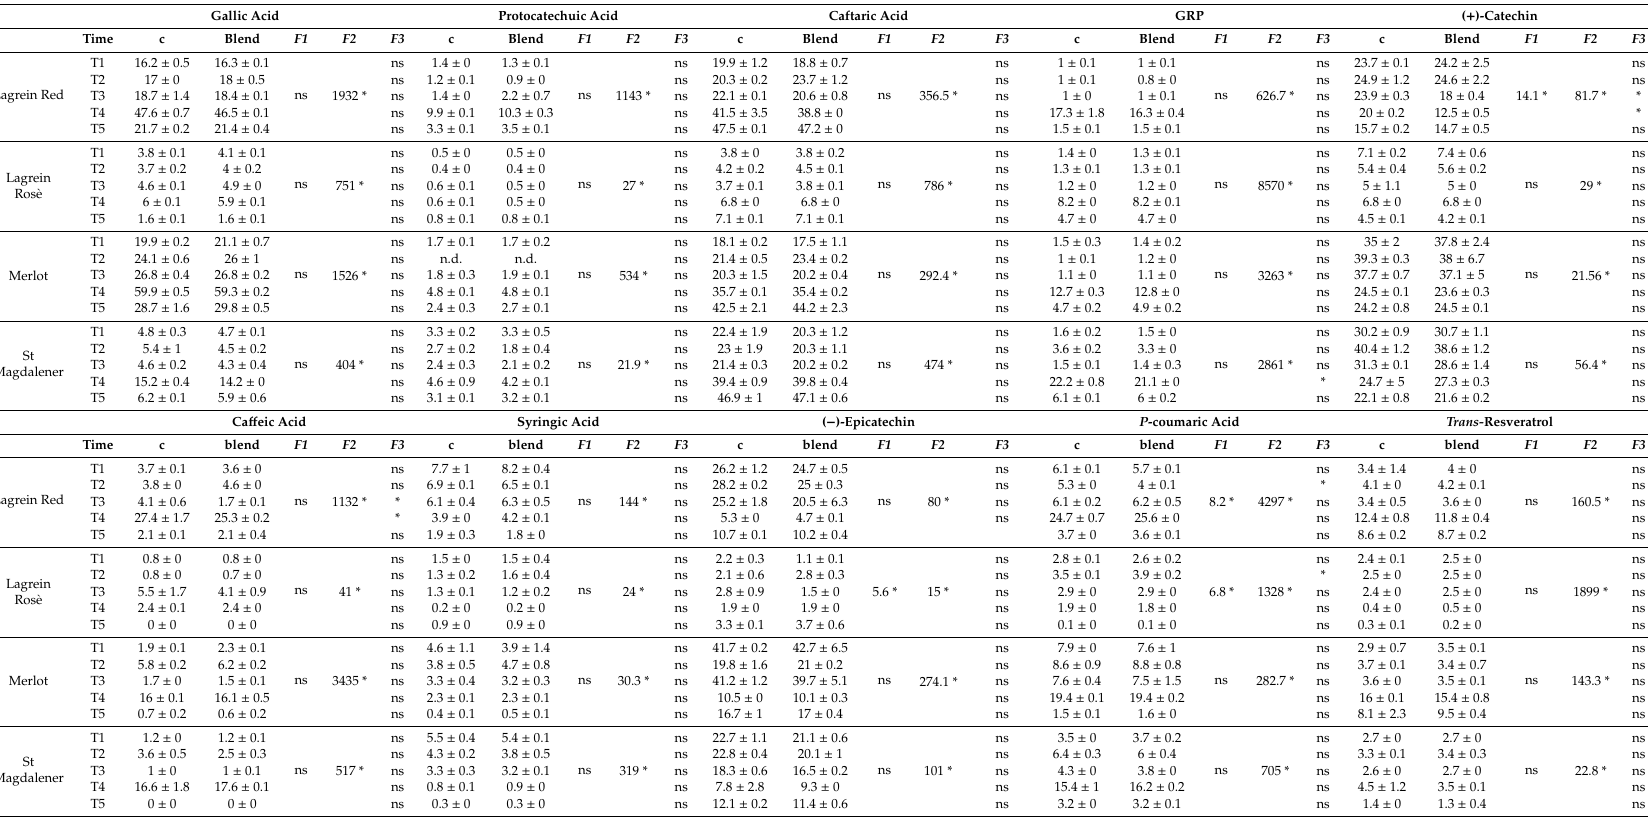
Table 1. Non-anthocyanin phenolic compounds (mg L − 1 ) and significance of the type of stopper and storage time on their